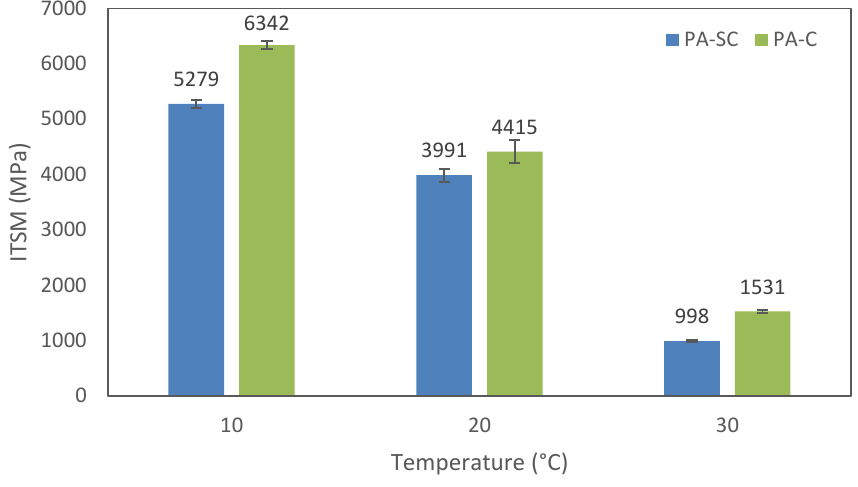
Figure 5. Average ITSM values for porous asphalt specimens.